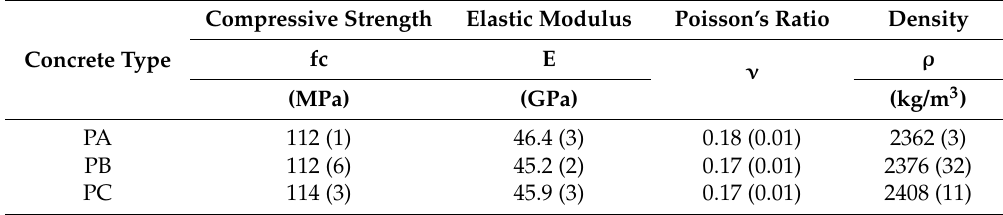
Table 2. Properties of concretes at an age around seven